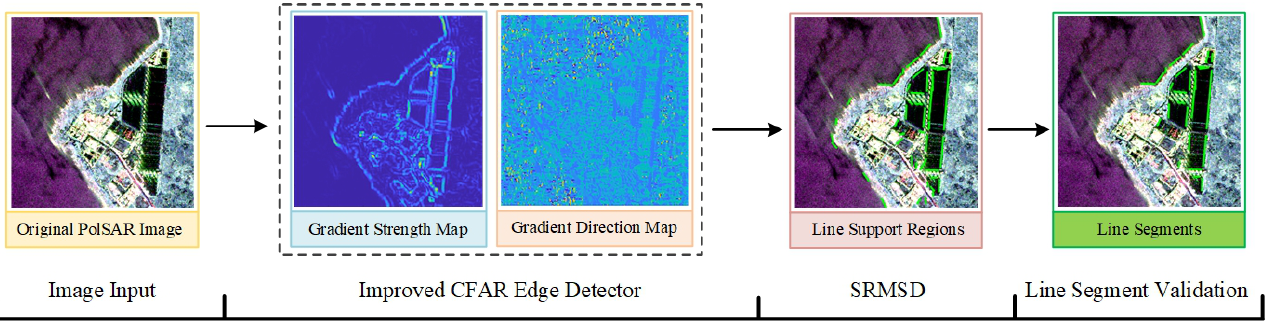
Figure 1. Flowchart of the